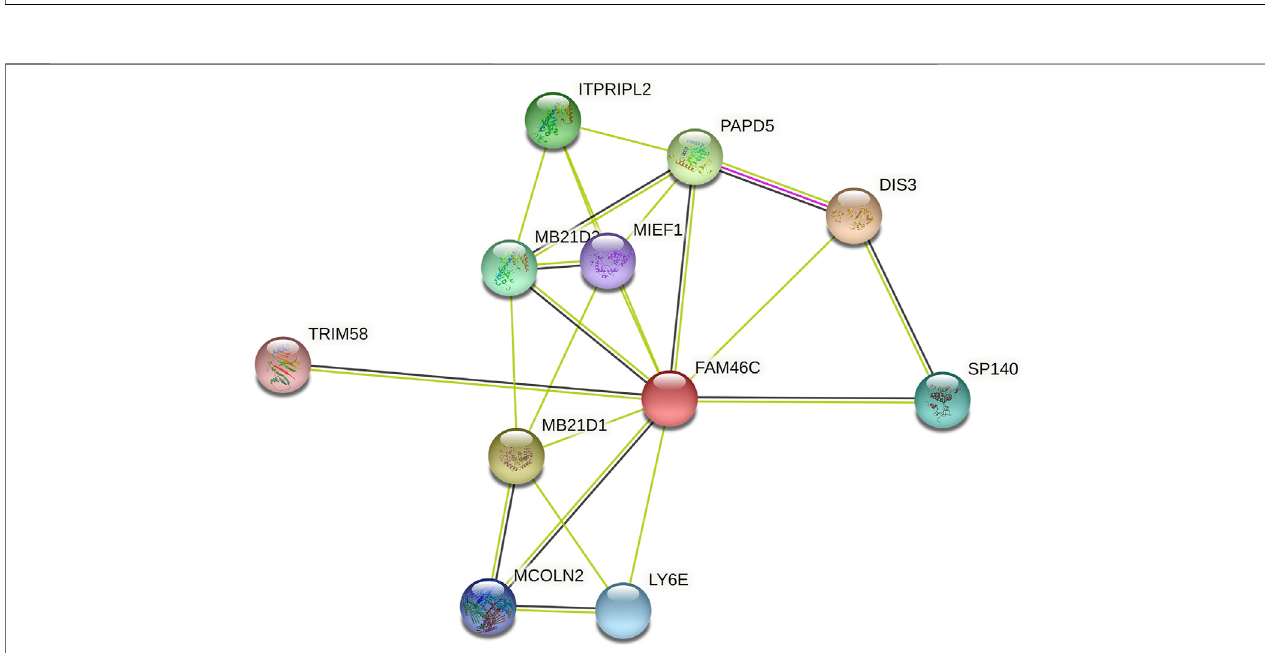
FIGURE 6 | FAM46C protein – protein interaction